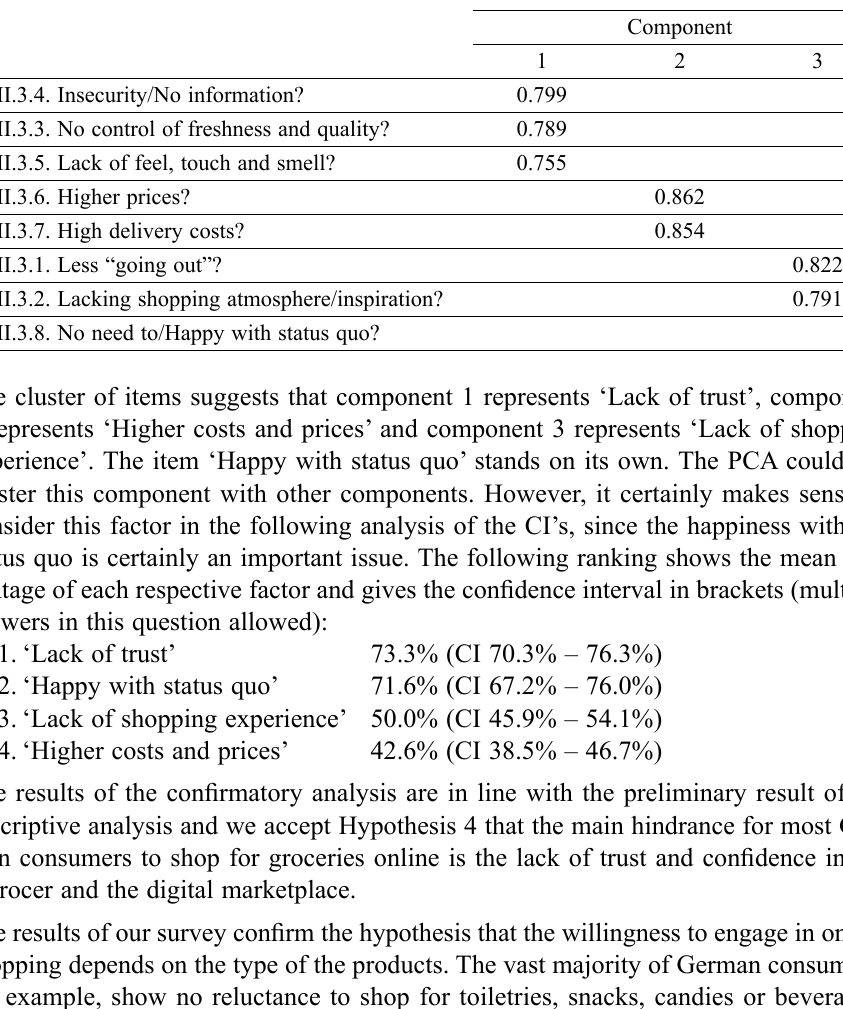
Table 1. Principal component for impediments to shop for groceries